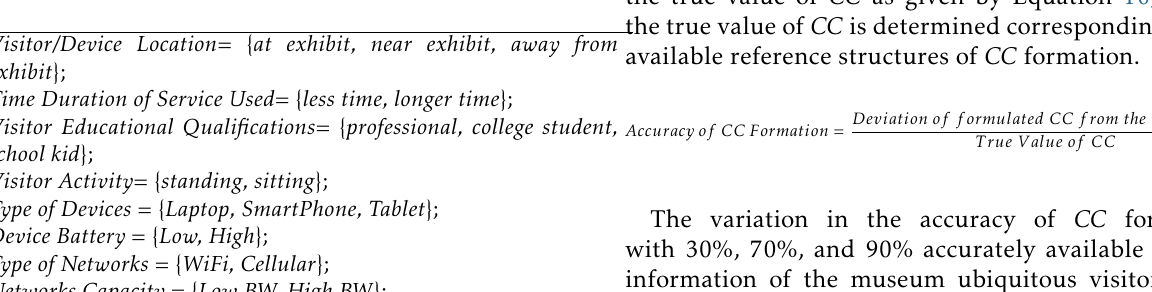
Table 1. Context Information Parameters with Possible Values